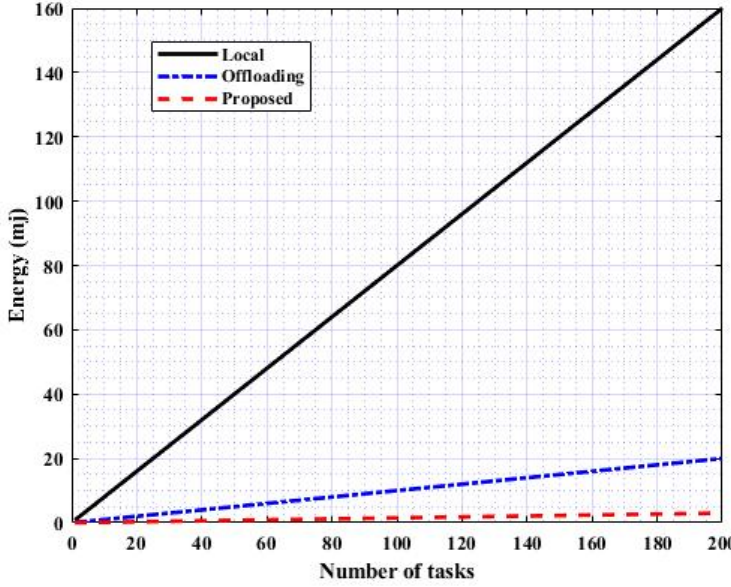
Figure 4. Performance vs. tasks—energy consumption.